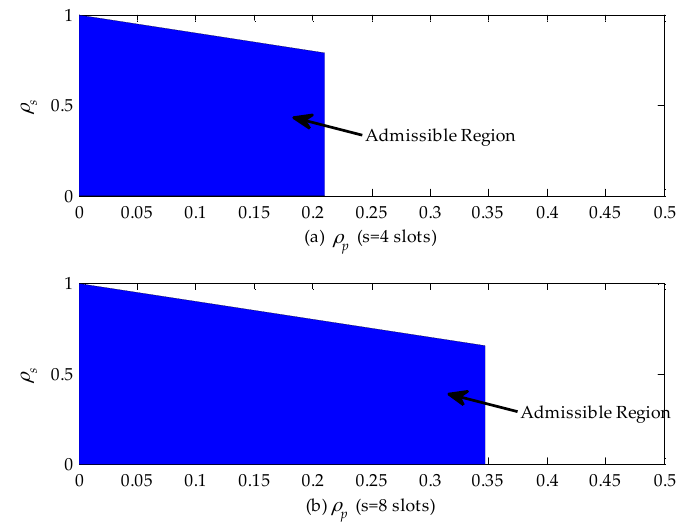
Figure 8. The admissible region of a cognitive radio (CR) network when the service time of the primary connection follows the upper-truncated Pareto distribution: ( a ) the maximum allowable delay is set to be four slots; and ( b ) the maximum allowable delay is set to be eight slots.